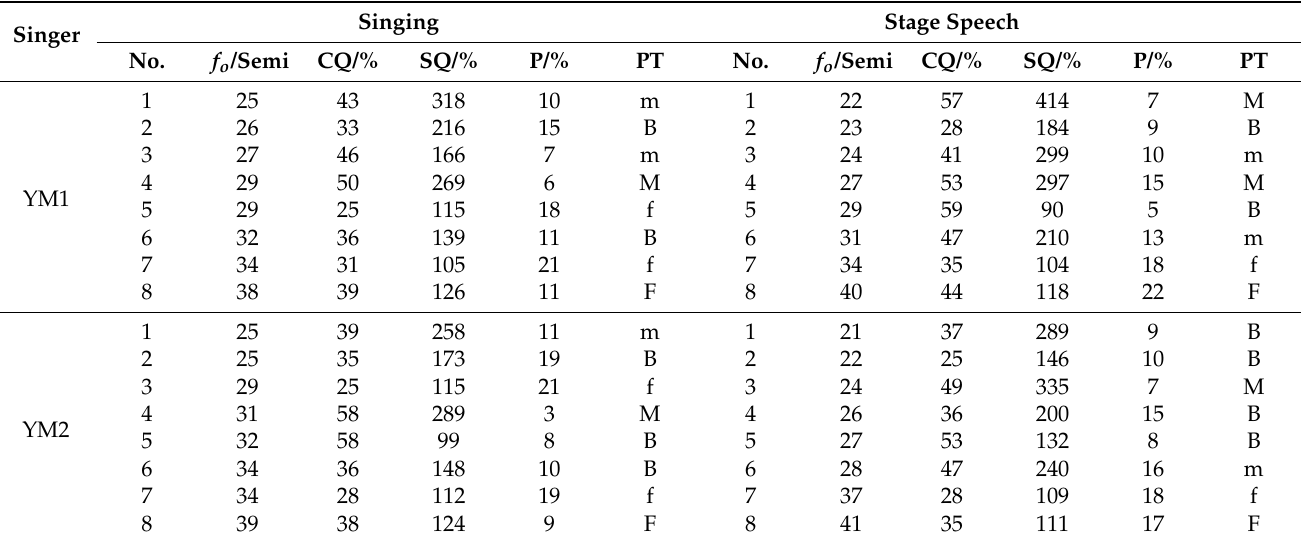
Table 1. EGG parameters and corresponding phonation type for each clustering centroid and the percentage of the data around the centroid. (P: percentage; PT: phonation types; m: modal voice; M: high adduction modal voice; B: breathy voice; f: untrained falsetto; F: high adduction